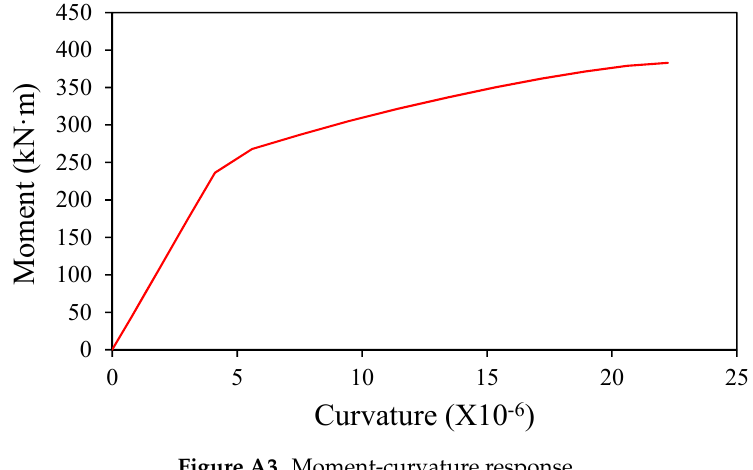
Figure A3. Moment-curvature response.